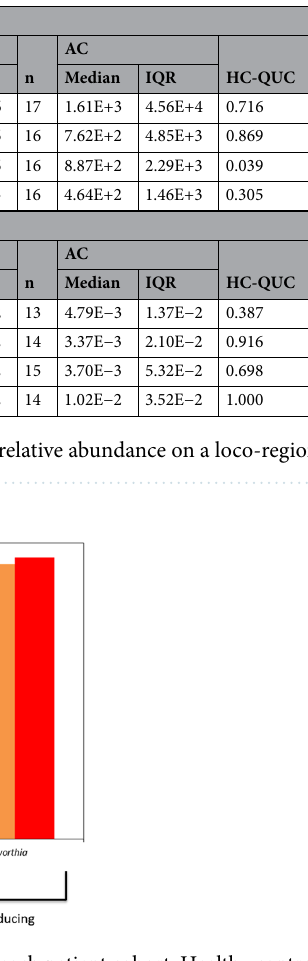
Figure 3. Colonisation rates of each bacterial target in each patient cohort. Healthy controls are represented in green, patients with quiescent UC in orange and patients with acute UC in